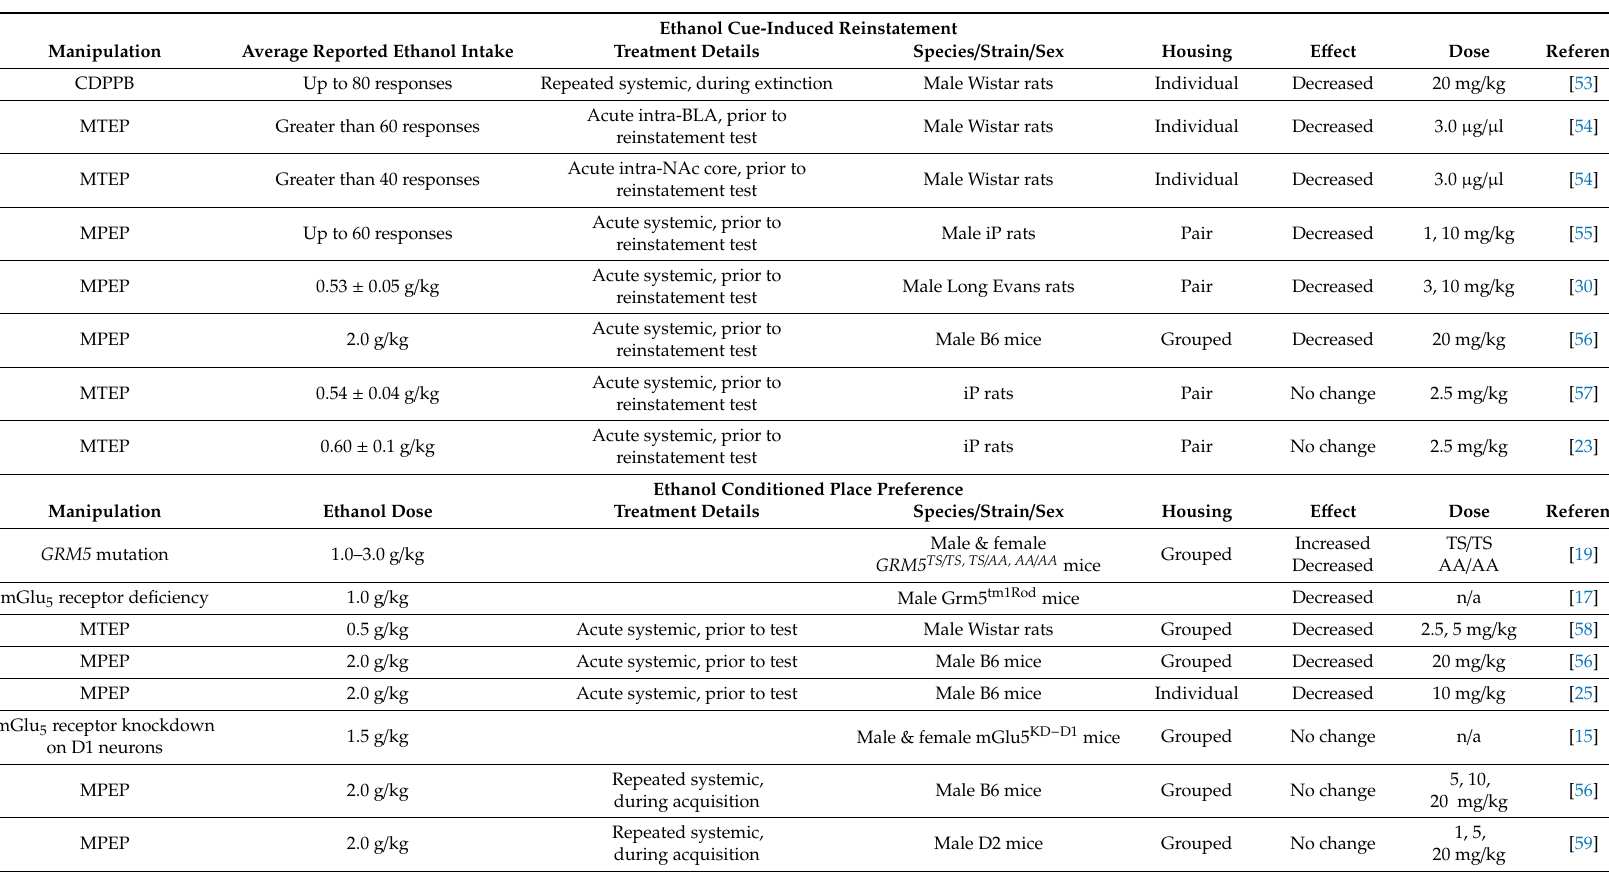
Table 2. Details from studies observing the e ff ect of mGlu5 receptor modulation on cue-induced reinstatement to seek ethanol and ethanol-conditioned place preference. Ethanol Cue-Induced Reinstatement Manipulation